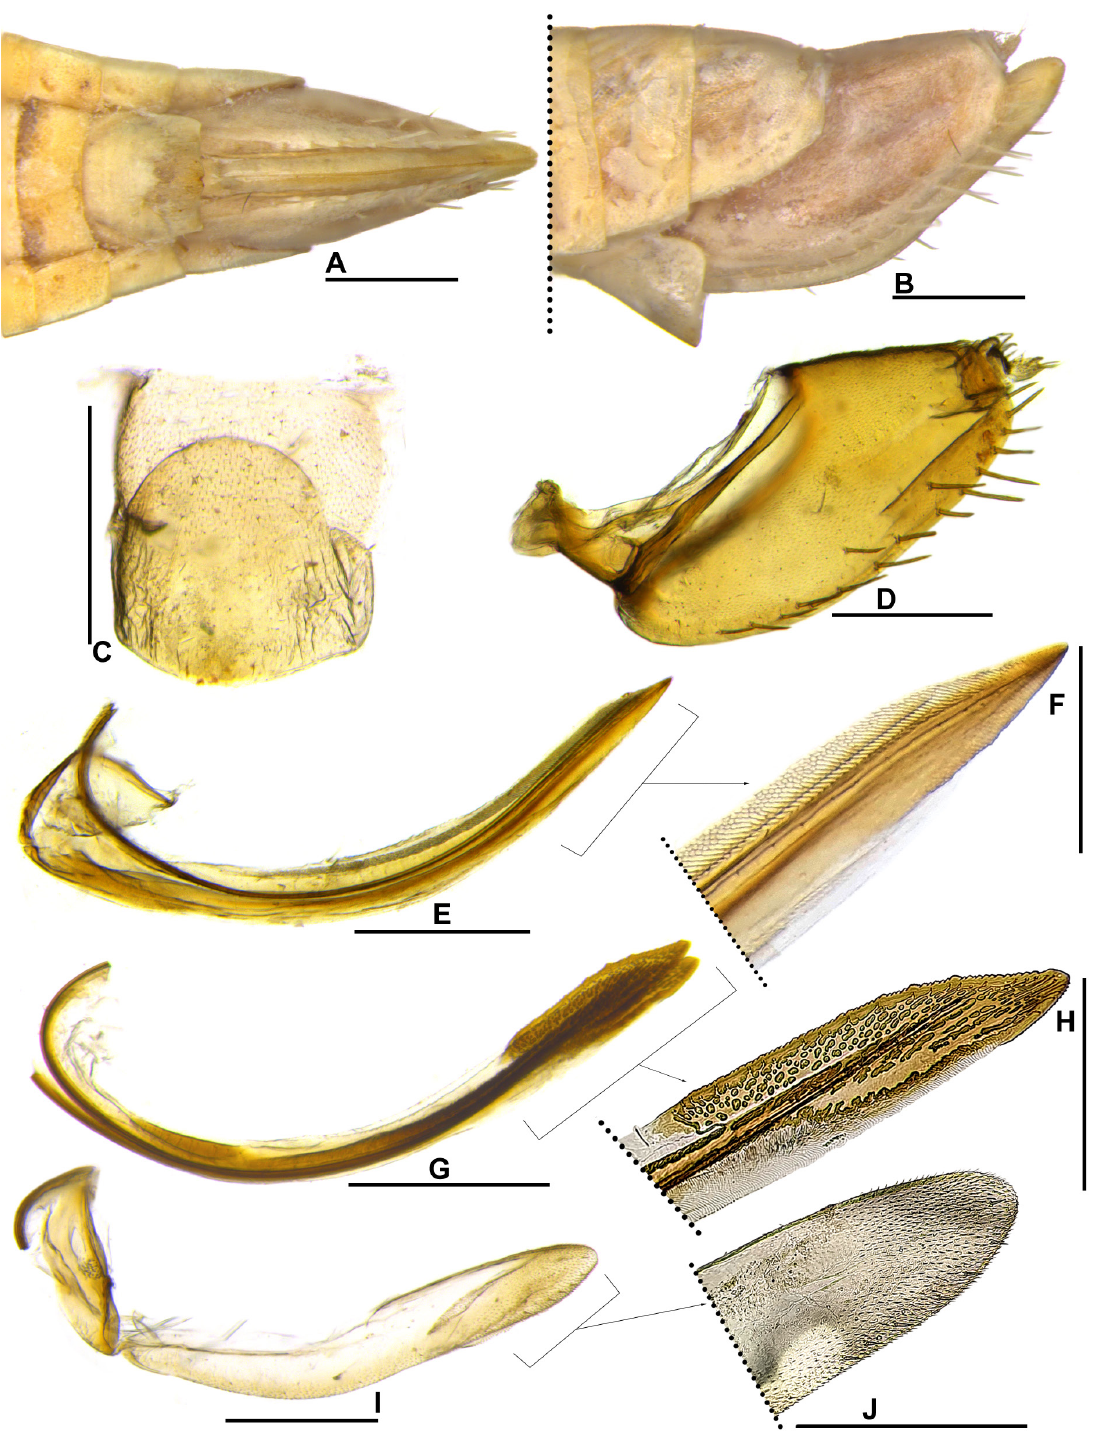
Fig. 2. Takiyaella anomala gen. et sp. nov., ♀, paratype (MNRJ). A . Posterior portion of abdomen, ventral view. B . Posterior portion of abdomen, lateral view. C . Sternite VII, ventral view. D . Pygofer and anal tube, lateral view. E . First valvifer and first valvula of ovipositor, lateral view. F . Apex of first valvula, lateral view. G . Second valvula of ovipositor, lateral view. H . Apex of second valvula, lateral view. I . Second valvifer and gonoplac, lateral view. J . Apex of gonoplac, lateral view. Scale bars: A–B = 1.0 mm; C–E, G, I = 0.5 mm; F, H, J = 0.3